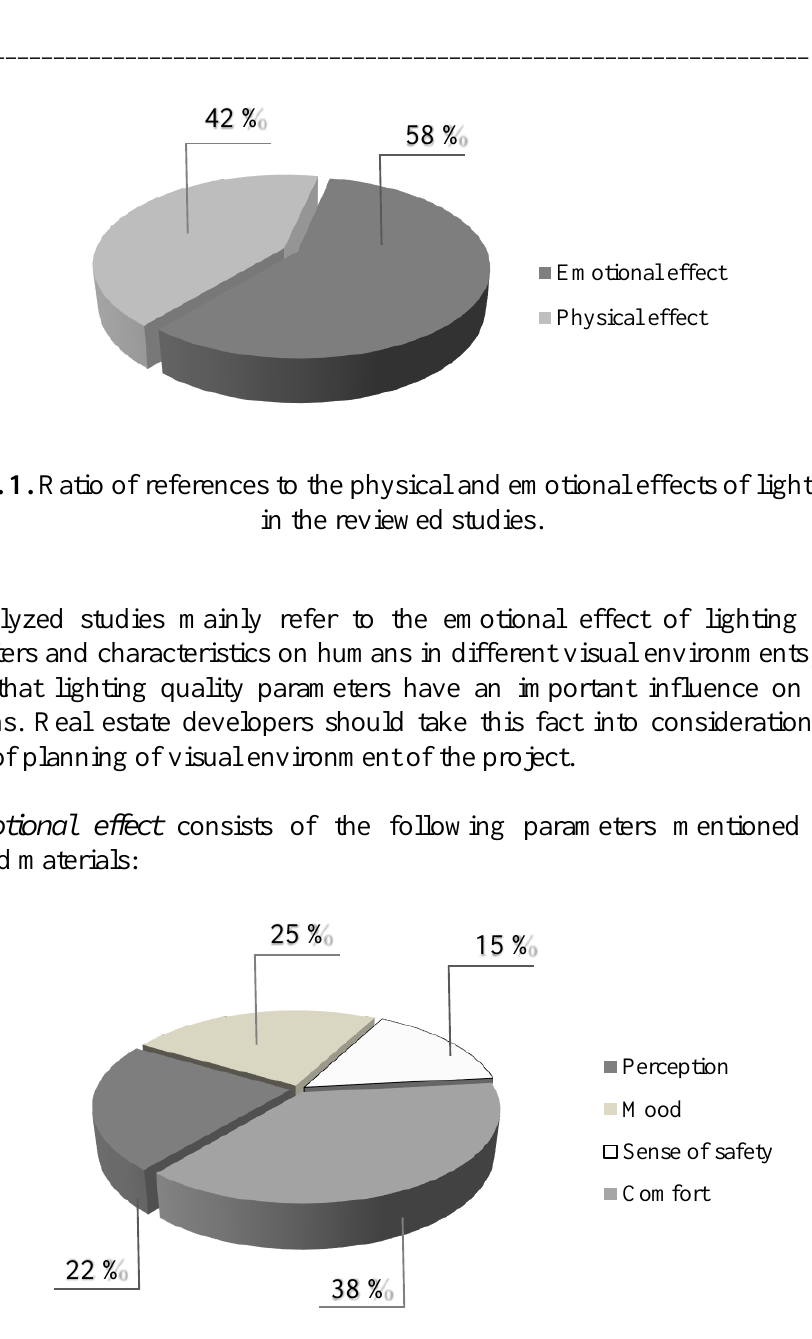
Fig. 2. Ratio of references to the emotional effects of lighting such as perception, mood, sense of safety and comfort in the reviewed